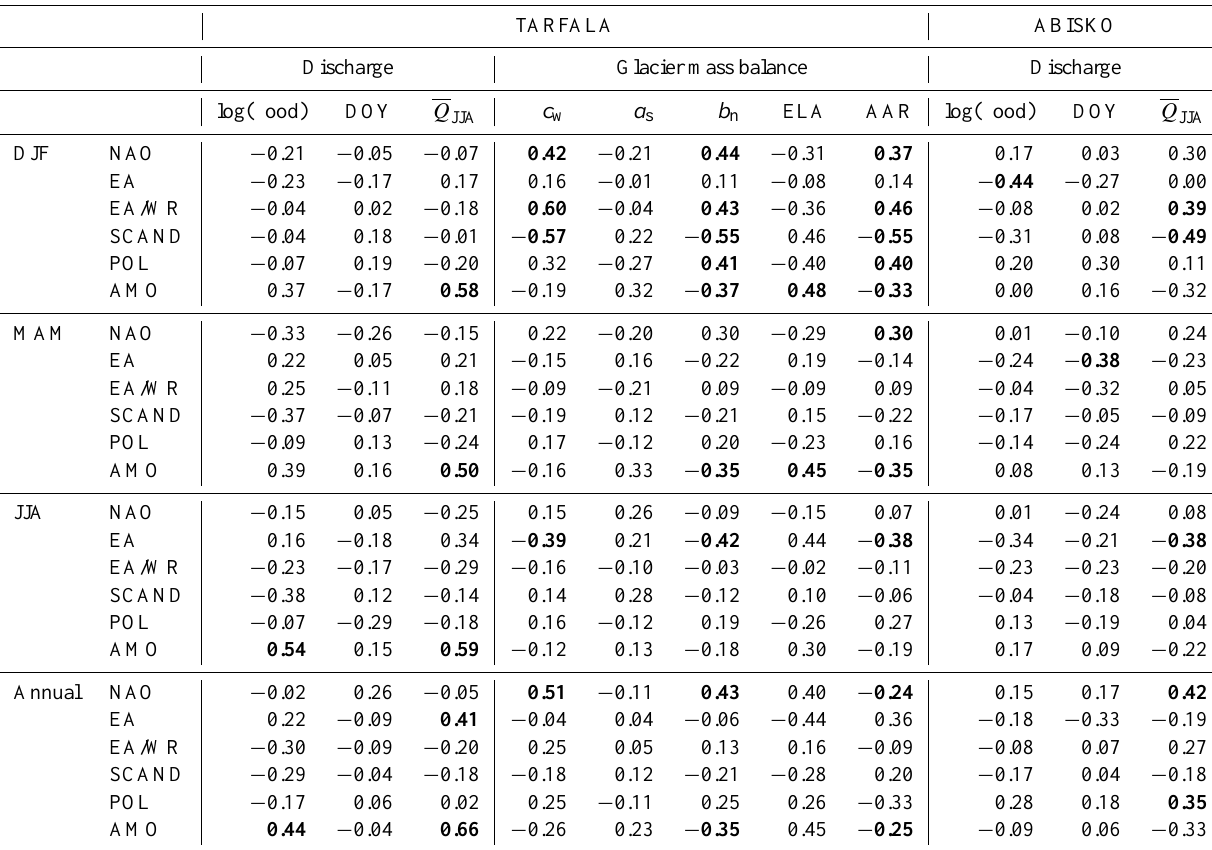
Table 7. Correlations between seasonal (3-months averaged) and annual (12-months averaged) anomalies of climate teleconnection patterns and annual maximum flood peaks [log(flood)], flood occurrence day (DOY), and mean summer discharge ( Q JJA ), for the Tarfala and Abisko catchments and the winter ( c w ), summer ( a s ), net balance ( b n ), equilibrium line altitude (ELA), and accumulation area ratio (AAR) estimates of Storglaci¨aren within the Tarfala catchment. The results are shown for the comparison period of 1985–2009. Correlations that are significant at the 5% significance level for a 2-sided test are highlighted in bold.